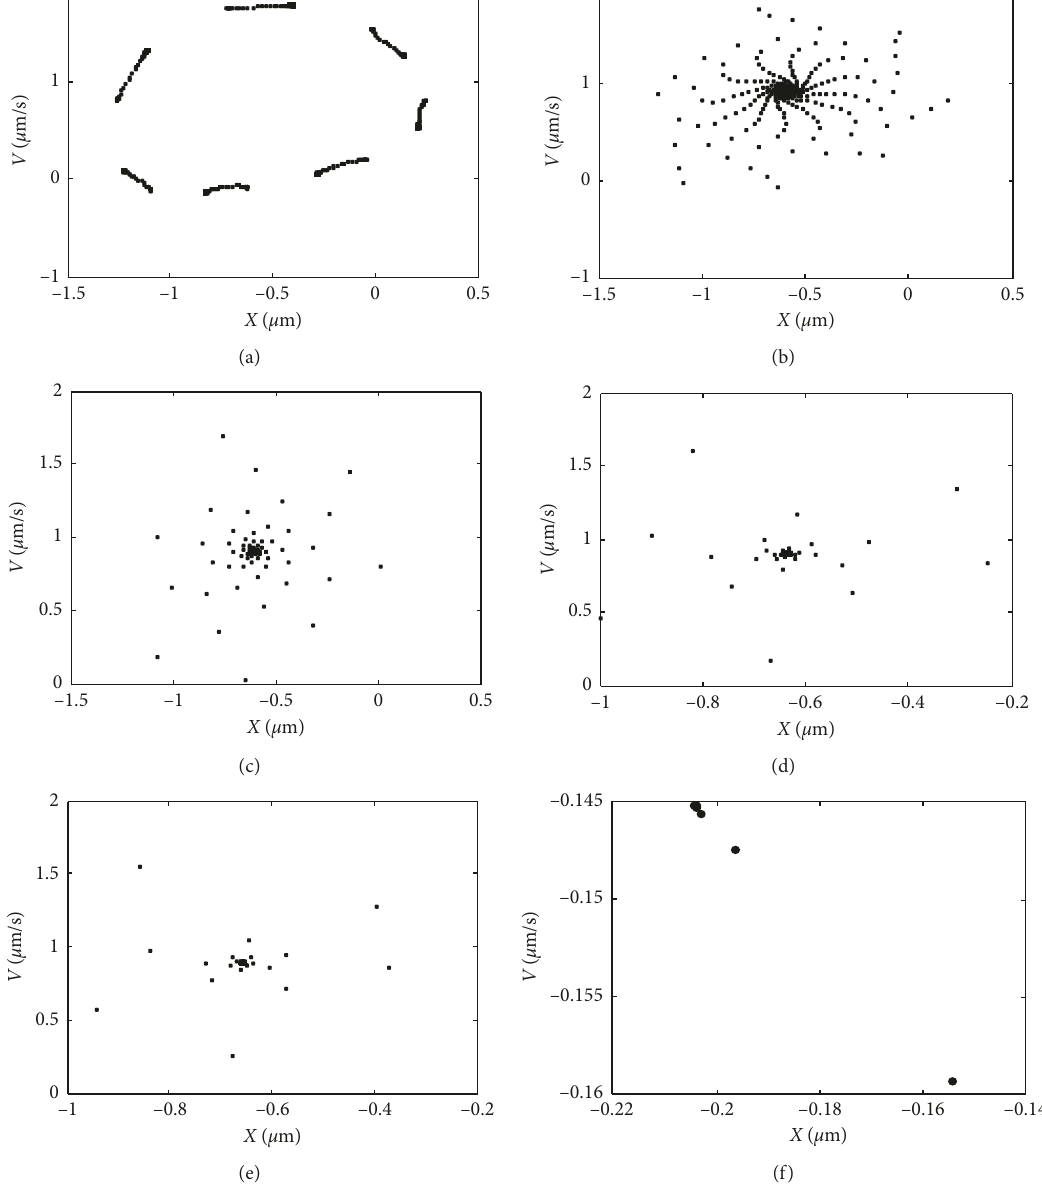
Figure 12: Poincar´e map. (a) C � 5, (b) C � 7, (c) C � 150, (d) C � 200, (e) C � 220, and (f) C �